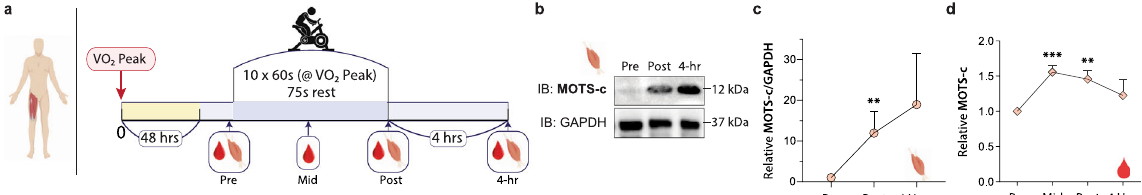
Fig. 1 MOTS-c responds to and regulates exercise in young subjects. a Schedule of exercise on a stationary bicycle and blood and skeletal muscle collection in young male subjects ( n = 10). b , c Representative western blot of MOTS-c from skeletal muscle and quanti fi cation ( n = 10; P = 0.0098). d Quanti fi cation of serum MOTS-c levels by ELISA ( n = 10; P = 0.0011; P = 0.0021, respectively). Data expressed as mean ± SEM. Wilcoxon matched-pairs two-sided signed rank test was used for ( c , d